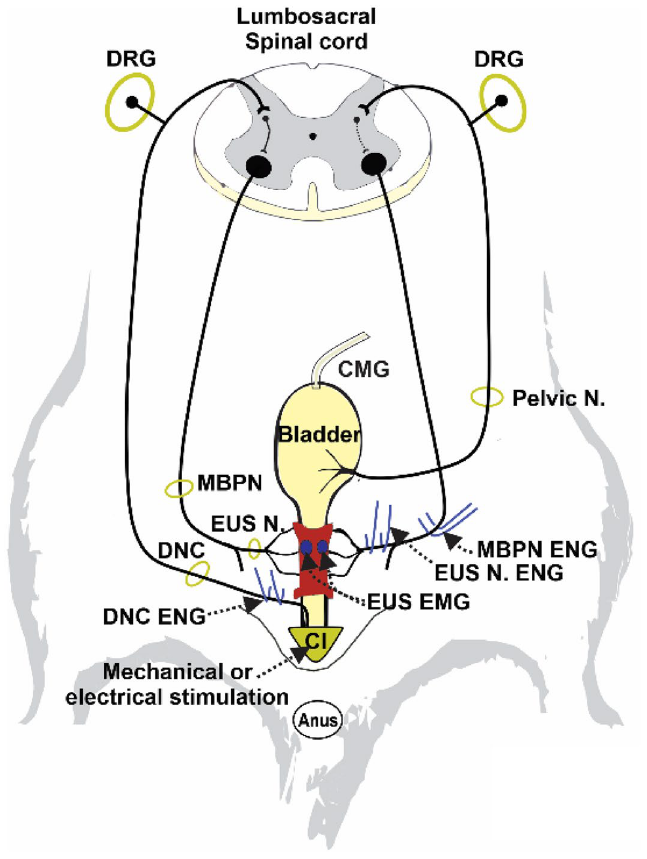
Figure 1. Diagram showing a ventral view of the lower urinary tract of the female rat and its peripheral and central neural control. Blue lines and small circles indicate electrode placement for electroneurograms (ENG) and EUS electromyograms (EMG), respectively, during clitoral mechanical stimulation and cystometrograms (CMG). DRG, dorsal root ganglia; MBPN, motor branch of the pudendal nerve; EUS N, external urethral sphincter nerve; DNC, dorsal nerve of the clitoris; Cl,